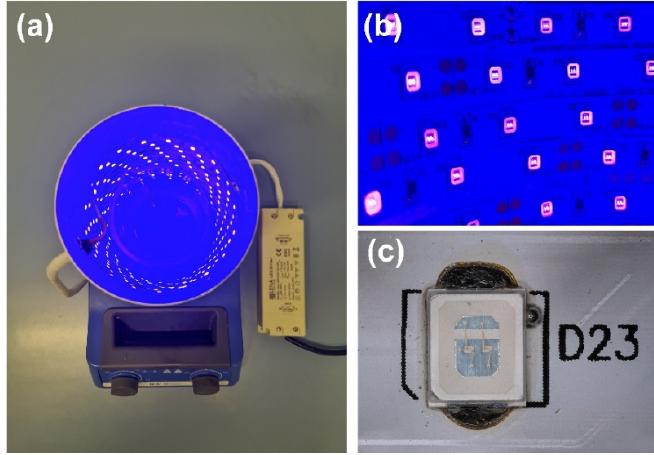
Figure 1. ( a ) UV-LED photocatalytic reactor, ( b ) UV-LED strip light source, and ( c ) focus on single SMD diode.